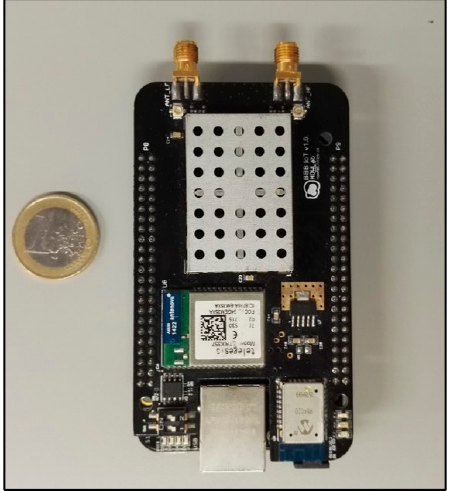
Figure 6. Control node: BeagleBone Black and IoT cape.